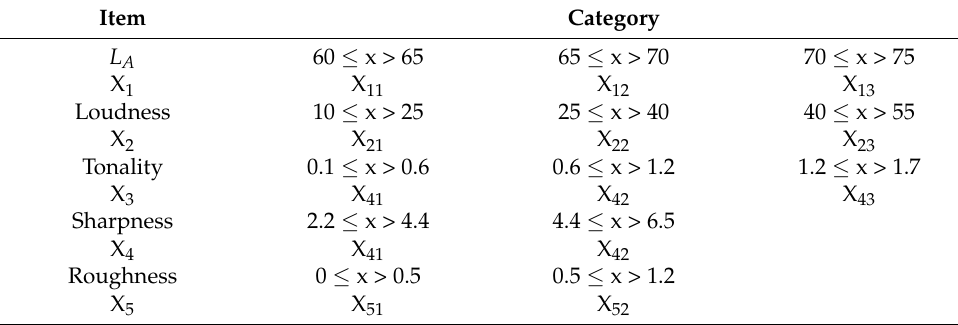
Table 3. Classification of items and categories of electric shaver